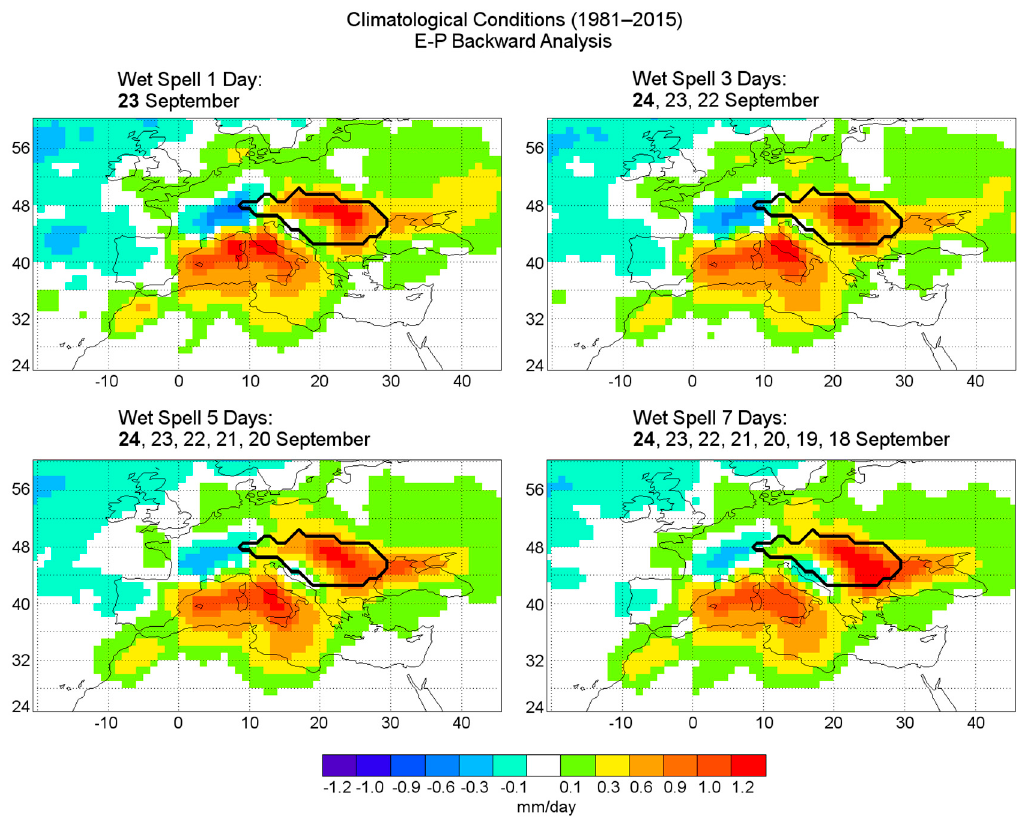
Figure 6. E − P climatological conditions from the backward analysis for 1981–2015 time period for the wet spell events on its different time scales (1, 3, 5 and 7 days). The black line contour corresponds to the Danube River Basin. Scale in mm/day.